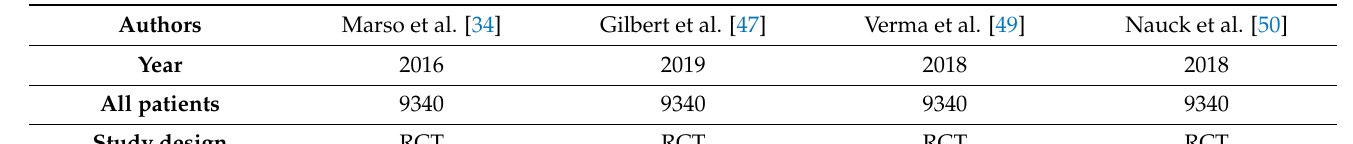
Table 6. Comparison of studies on the effect of liraglutide treatment on cardiovascular outcom- es